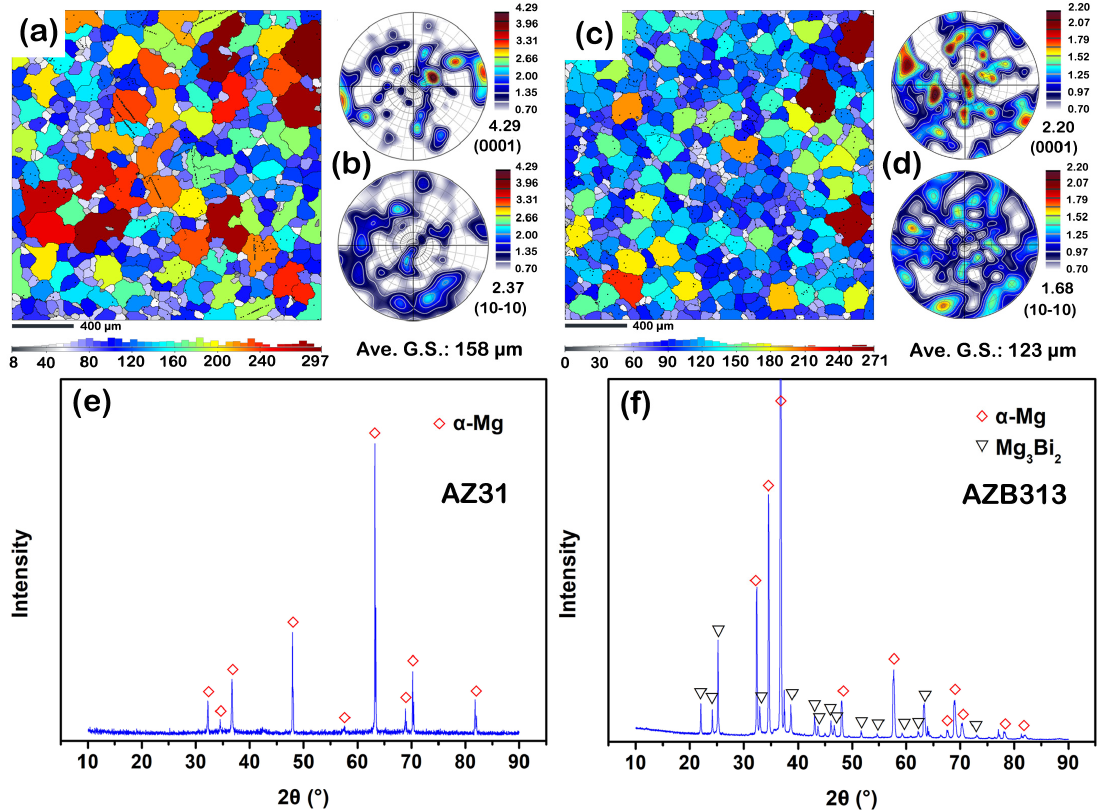
Figure 1. ( a , c ) EBSD inverse pole figure maps showing grain size distribution; ( b , d ) crystal orientation distribution maps including (0001) and (10-10) pole figures; ( e , f ) XRD results of as-cast AZ31 and AZB313 alloys, respectively.